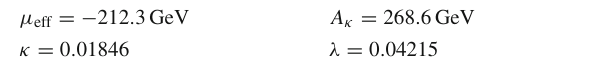
Table 3 Results for the parameter scan in the NMSSM with μ eff at the electroweak scale, the soft SUSY-breaking parameter A κ and the couplings κ and λ leading to the mass spectrum shown in Table 2 μ = − 212 . 3GeV A κ = 268 . eff